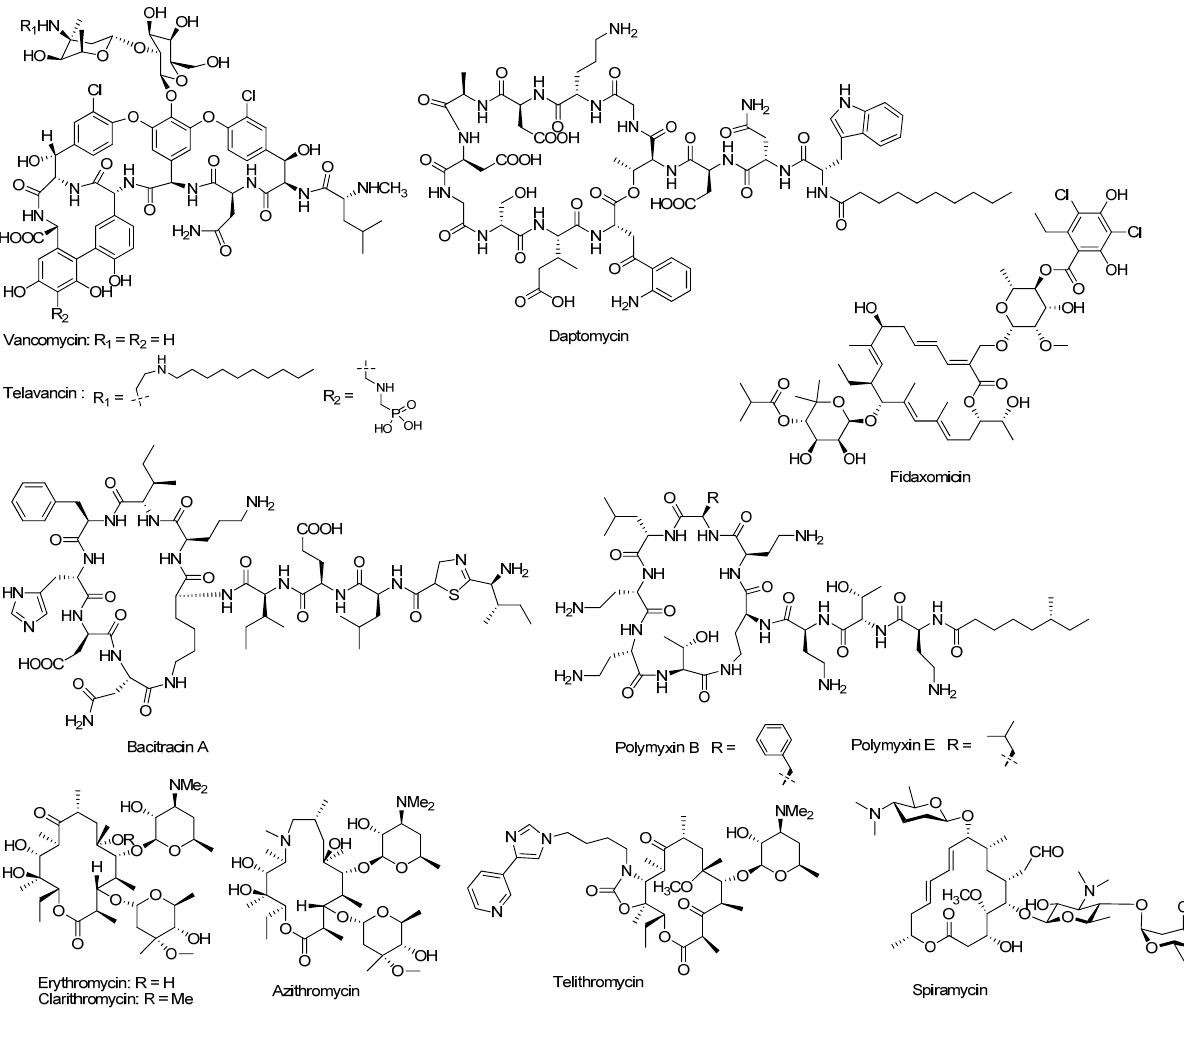
Figure 2. Additional macrocyclic